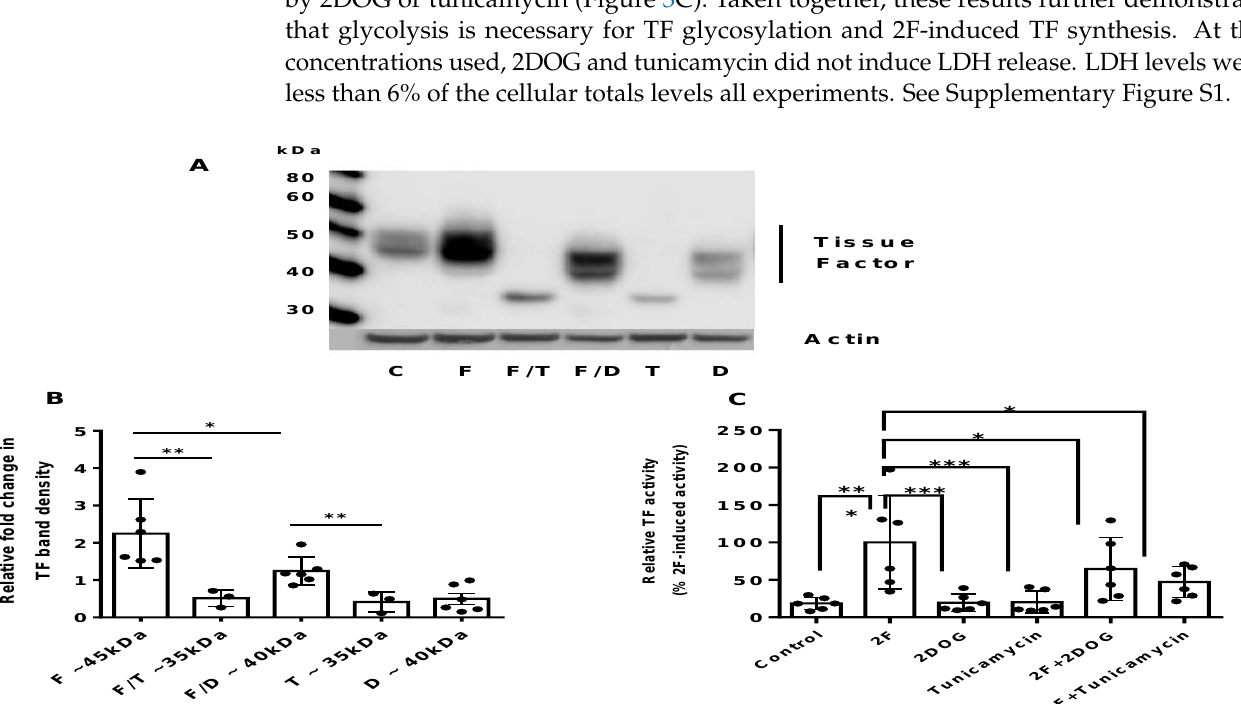
Figure 3. 2-Deoxyglucose and tunicamycin reduce PAR2-induced TF synthesis and its molecular weight in HTECs. ( A ) Representative Western blot showing the effect of 2-deoxyglucose or tunicamycin based on amount and molecular weight of TF induced by 2F. ( B ) Semiquantitative analysis of the change in expression of TF induced by 2F when cells were cultured in the presence of 2DOG (5 mM) or tunicamycin (4 µ g/mL) as measured by Western blot. ( C ) A chromogenic factor Xa activity assay was used to assess the TF activity of conditioned medium (secreted TF). Cells were treated with or without 2F (2 µ M) in the presence of either 2-deoxyglucose (5 mM) or tunicamycin (4 µ g/mL). The experiment was repeated ≥ 3 times with different donor cells. The bars represent the mean ± SD. A significant * ( p < 0.05), ** ( p < 0.01), *** ( p < 0.001) increase in TF synthesis compared to vehicle treatment (control). C = control (vehicle), F = 2f-LIGRLO-NH2, (2 µ M), D = 2-deoxyglucose (5 mM), and T = tunicamycin (4 mg/mL).